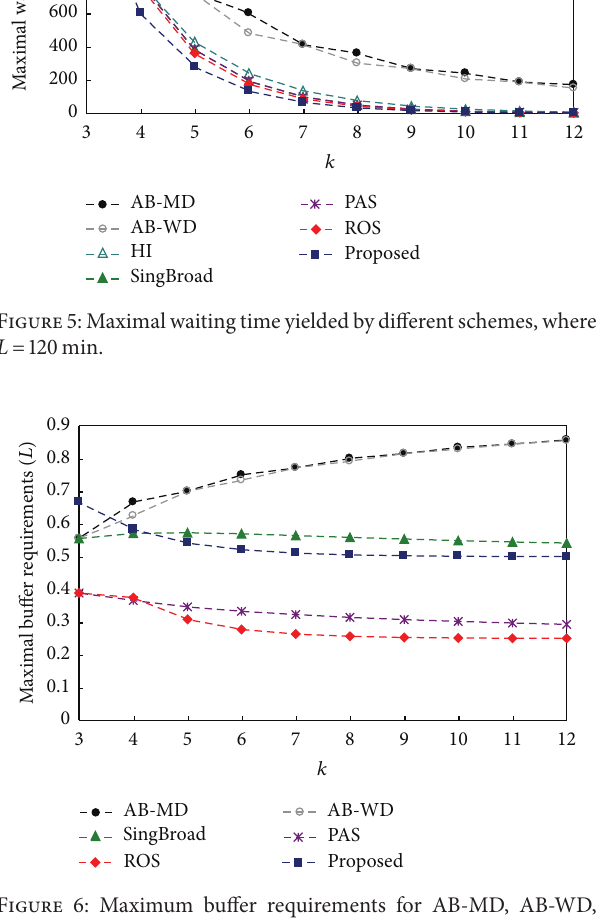
480, 240, 194, 194, 175, and 133 s, respectively. In this case, the waiting times for the proposed scheme are 78%, 72%, 45%, 31%, 31%, and 24% smaller than those of AB-MD, AB-WD, HI, SingBroad, PAS, and ROS,